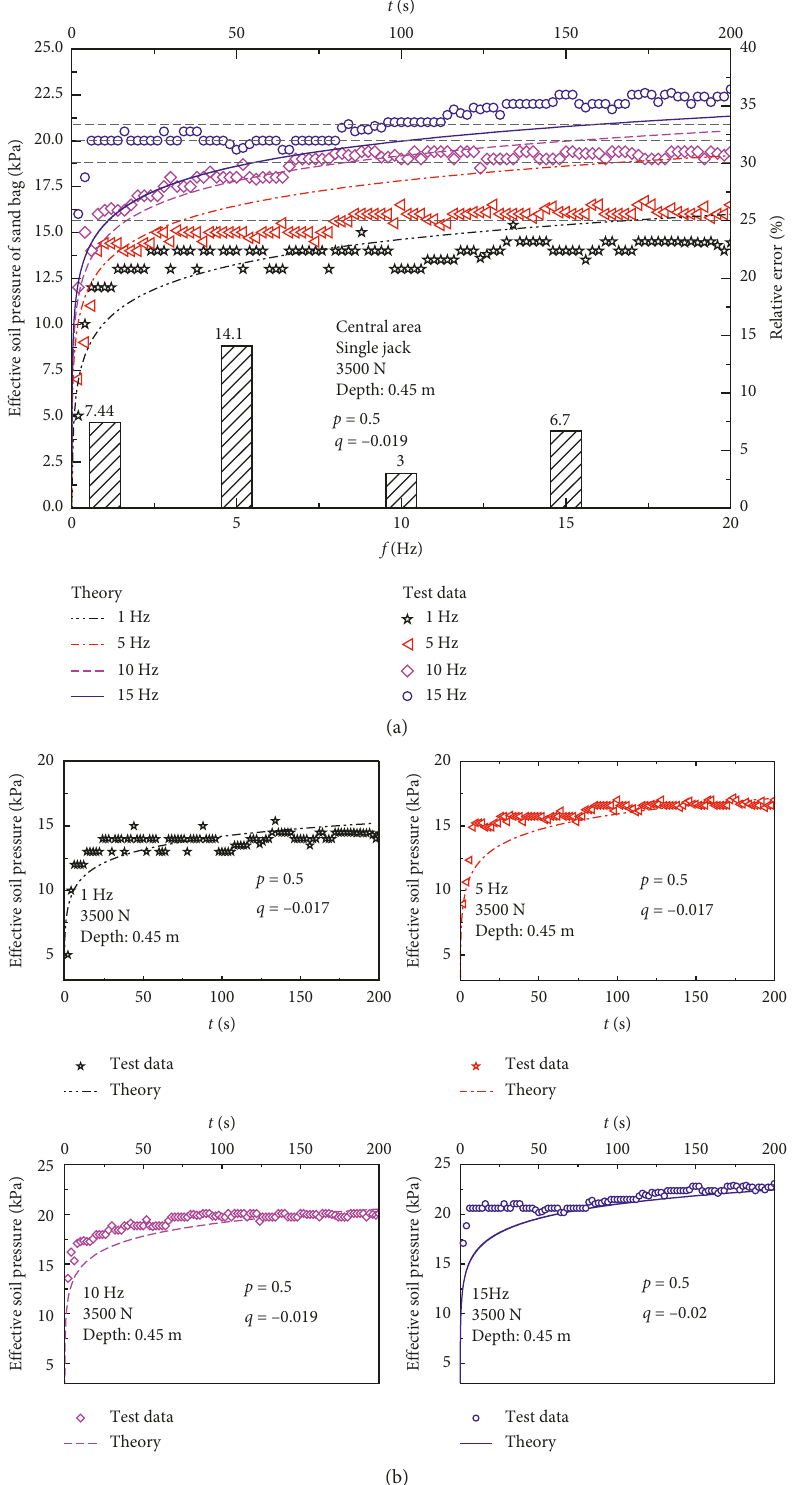
Figure 13: Variation in the effective soil pressure versus time curve under different excitation frequencies (sand